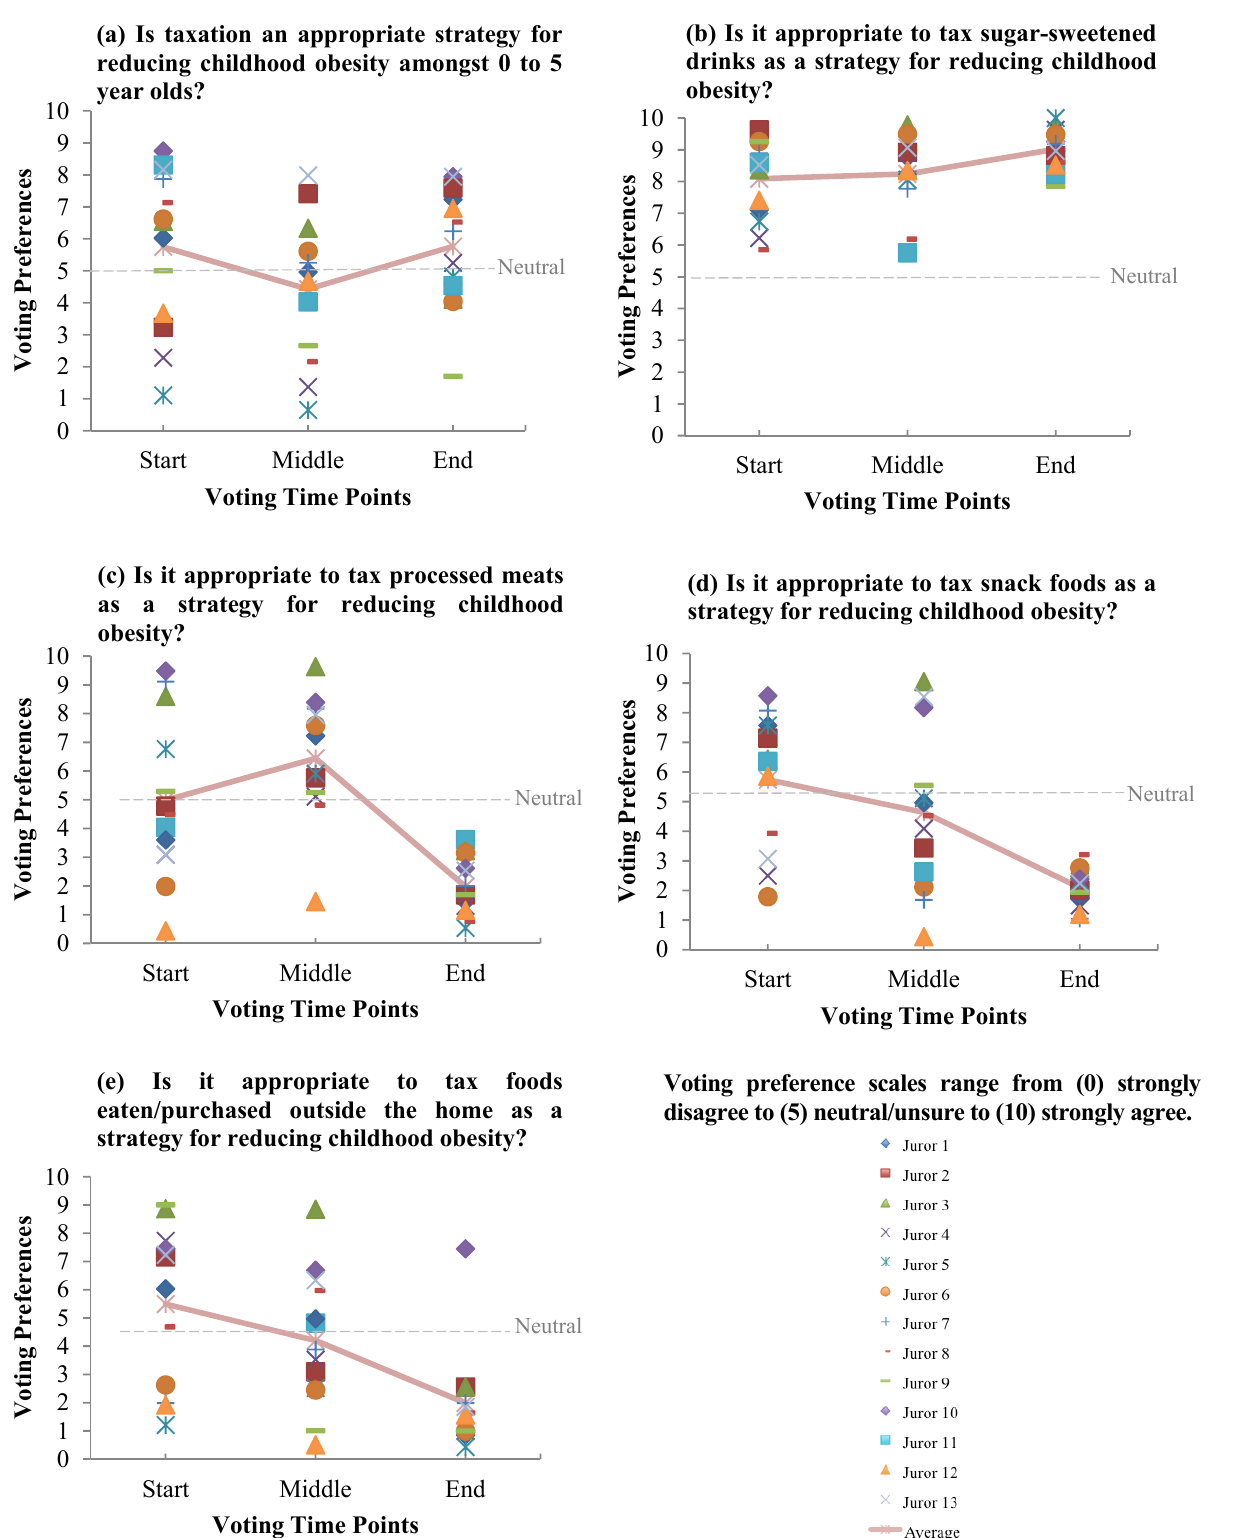
Figure 1. Individual and average voting preferences at three time points for the five questions: ( a ) Taxation. ( b ) Sugar-sweetened drinks. ( c ) Processed meats. ( d ) Snack foods. ( e ) Foods eaten/purchased outside the home.